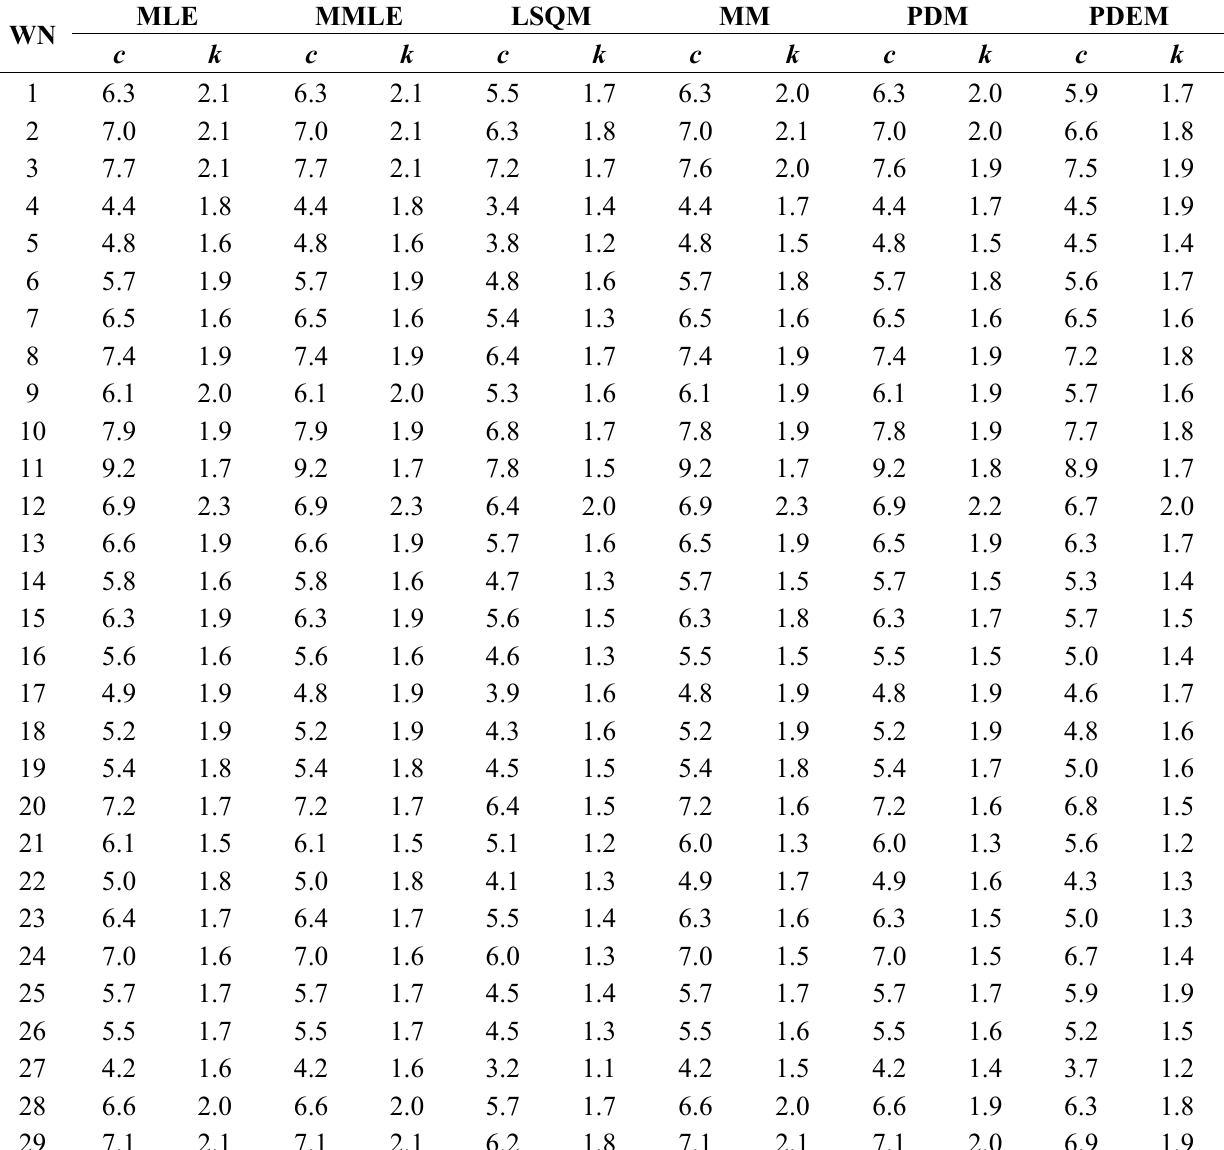
Table 2. Weibull PDF parameters: scale parameter c in m/s and unitless shape parameter k